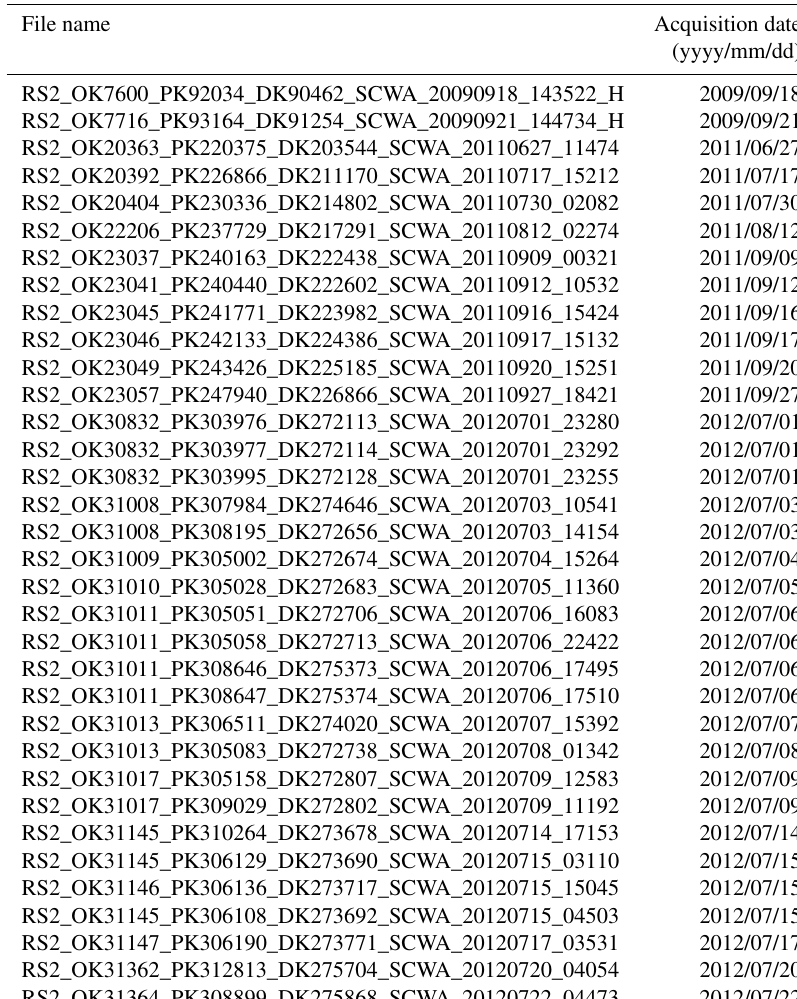
Table A1. Table of satellite images used in this study. The first column is the acquisition file name, and the second column contains the date that the image was